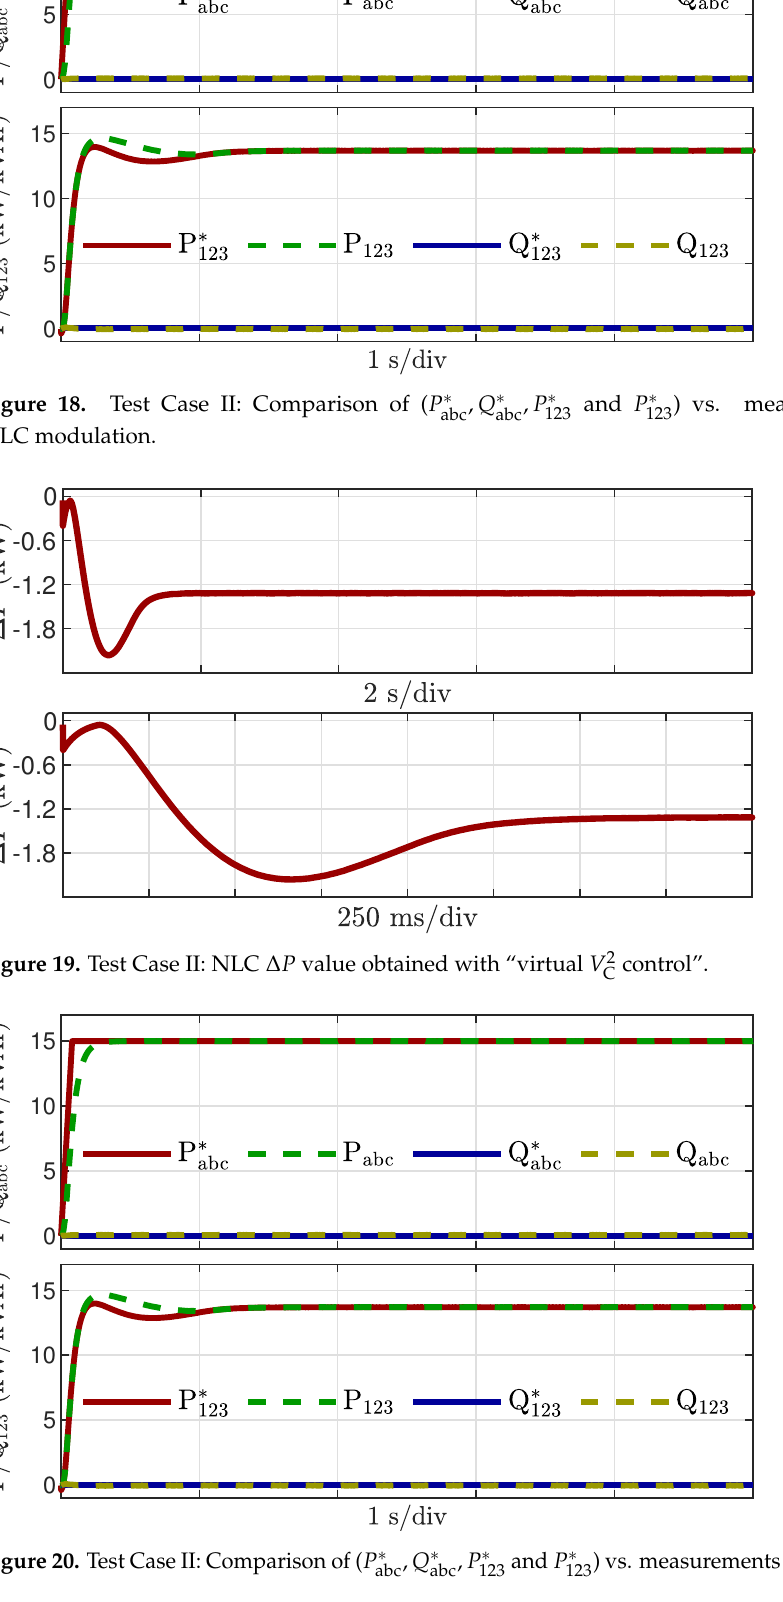
, Q ∗ , P ∗ and P ∗ ) vs. measurements under 123 123 abc abc